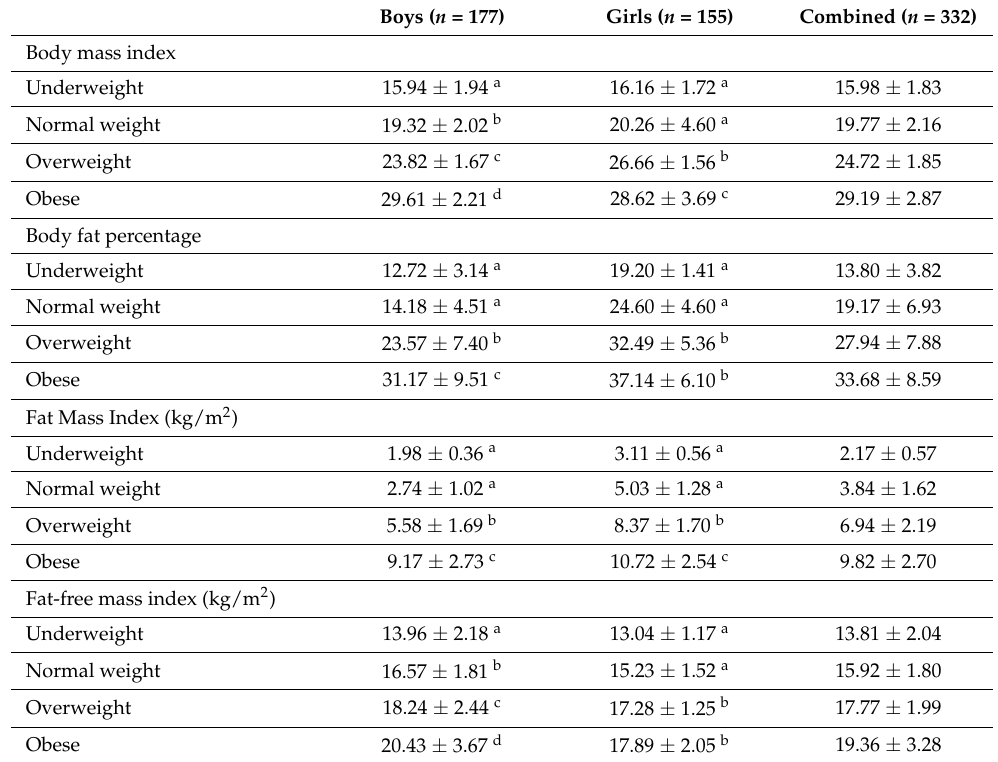
Table 2. Descriptive participant characteristics by BMI